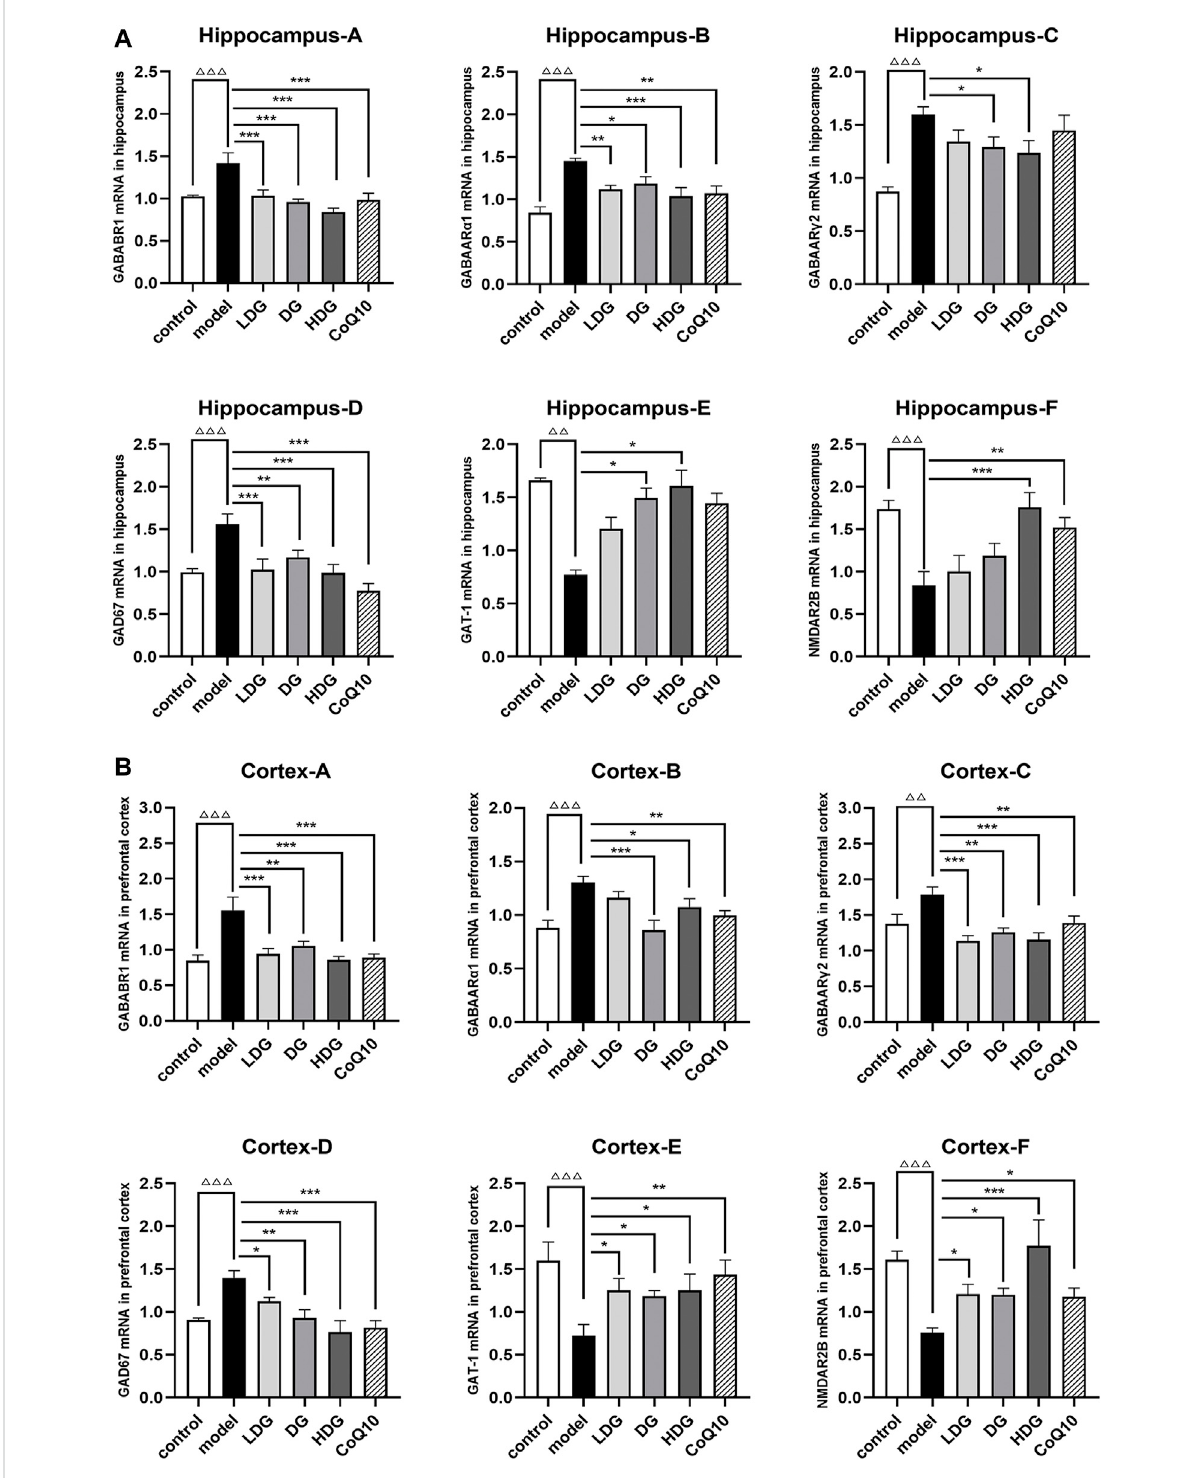
FIGURE 9 Expression levels of GABA/Glu pathway-related genes in the hippocampus and cortex. Relative mRNA expression levels of GABAAR α 1, GABAAR γ 2, GABABR1, GAD67, GAT-1 and NR2B in the hippocampus (A) and prefrontal cortex (B) were detected by real time-PCR analysis respectively. Data were expressed as (mean ± SD), ΔΔ p < 0.01, ΔΔΔ p < 0.001 vs. control group; * p < 0.05, ** p < 0.01, *** p < 0.001 vs. CF model group ( n =